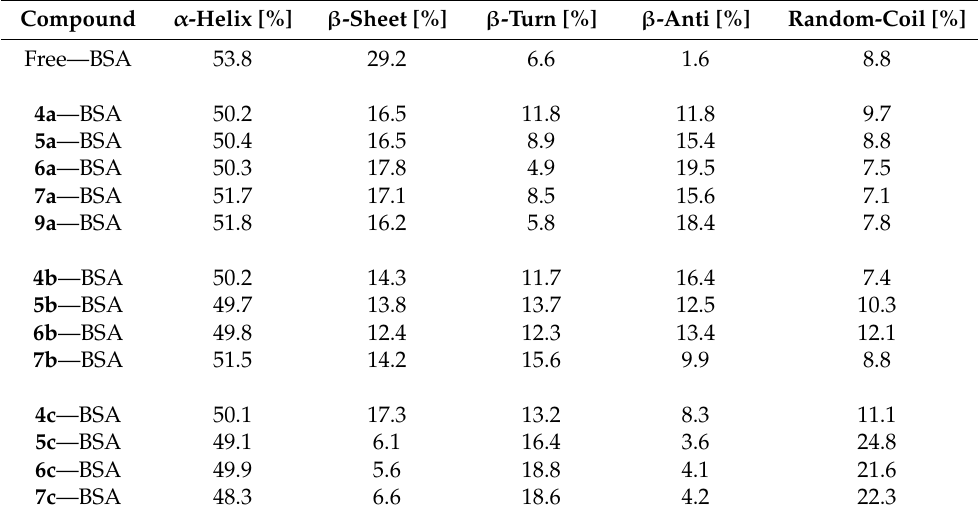
Table 6. Secondary structure of free BSA and BSA-drug complexes at pH = 7.5 calculated from Amide I bond obtained by FT-IR.